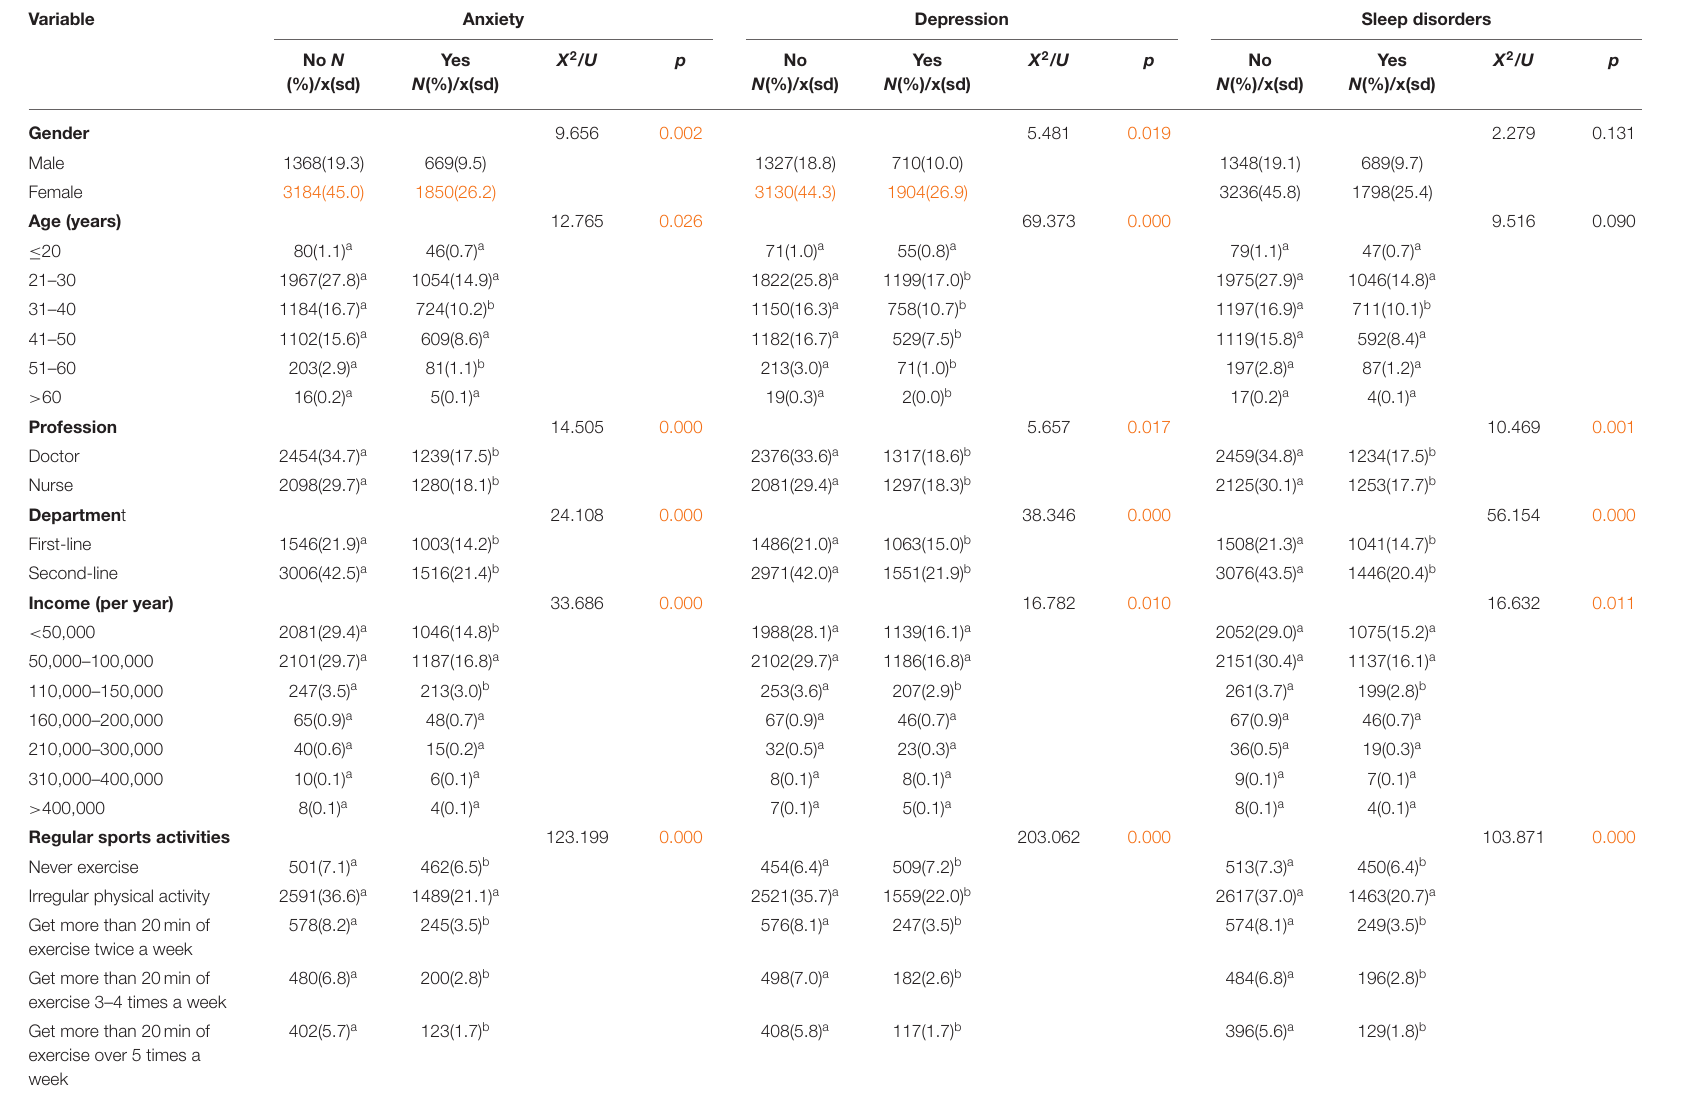
TABLE 2 | Variables of psychological symptoms of Chinese medical staff during